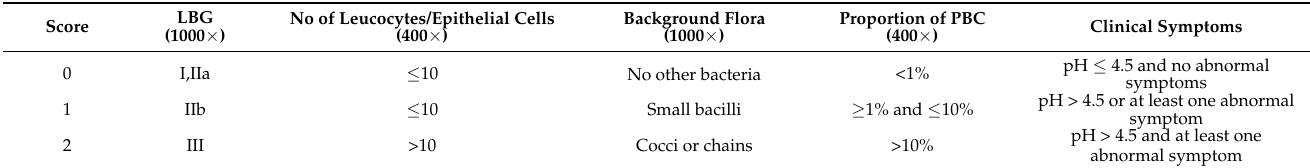
Figure 2. Phase-contrast images in 400× magnification after Gram staining. ( a ) AV with lactobacilli grade I. ( b ) AV with lactobacilli grade IIb. ( c ) AV with lactobacilli grade III (A microflora devoid of lactobacillus morphotypes). ( d ) Phase-contrast images in 1000× magnification full bacterial vaginosis; the red arrows illustrate the parabasal cells sign of vaginitis; the blue arrows indicate leukocytes; the orange arrows indicate the biofilm of coccoid bacteria. Table 1. Diagnostic criteria for AV Gram staining with clinical symptoms (Dong M. et al.